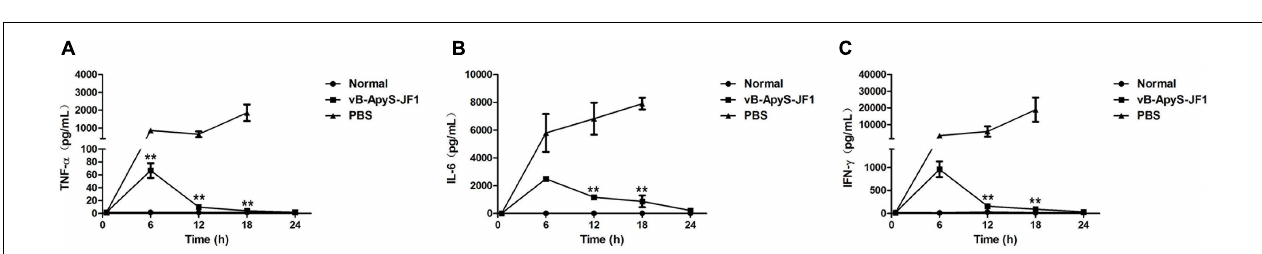
FIGURE 8 | Histopathology of different tissues. The lungs, livers, spleens, and kidneys of mice from each group were removed 12 h after challenge and immediately placed in 4% formalin. The formalin-fixed tissues were then processed, stained with hematoxylin and eosin, and analyzed by microscopy. The main lesions of each tissue were indicated by arrows.